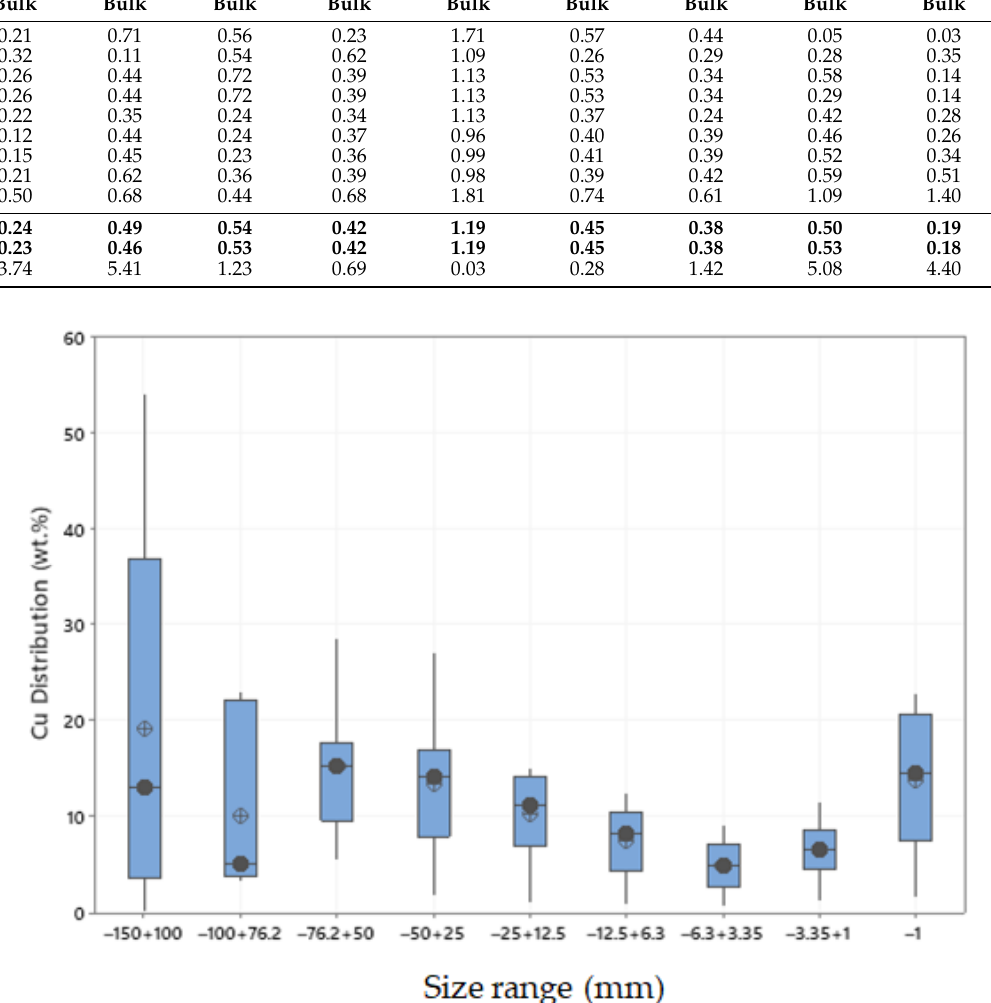
Figure 5. Box plot showing the variation of the distribution of copper as a function of size range (in mm). Black circles represent the median and void circles the mean.